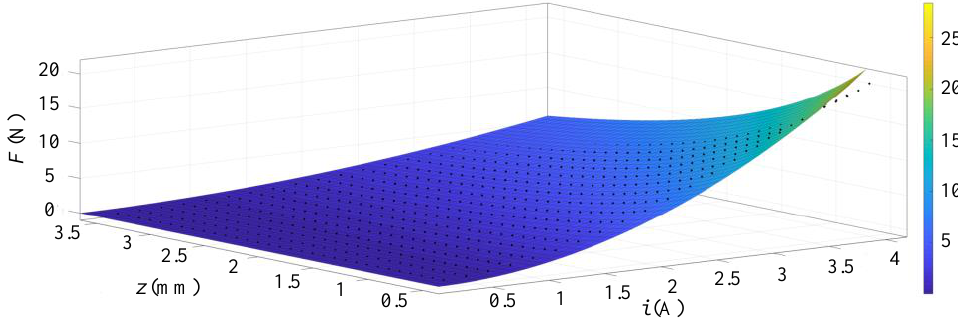
Figure 7. Fitting surface generated from the FEM analysis result data.